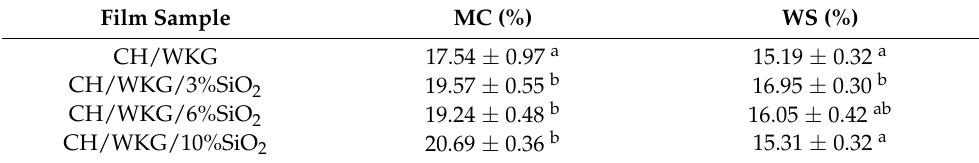
Table 1. Moisture content (MC) and water solubility (WS) of the films. The averages of the results followed by the same letter ( a, b ) in the same column do not differ from each other ( p <